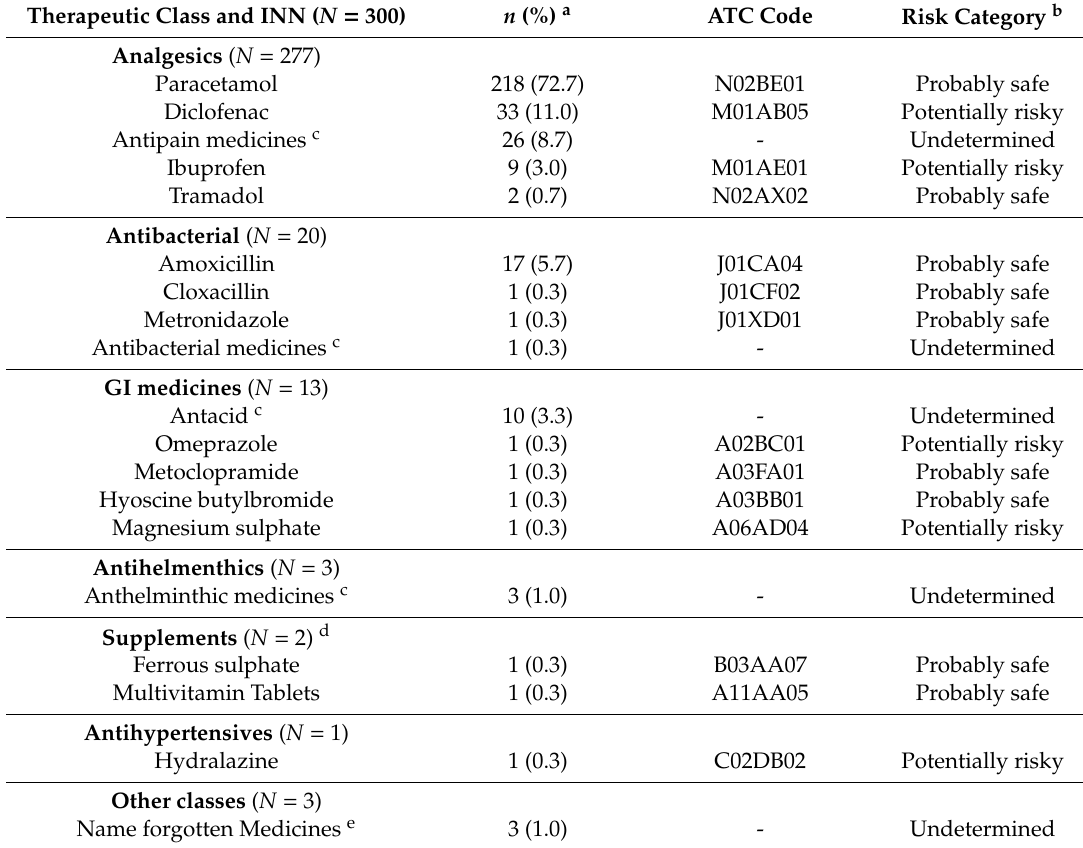
Table 2. Self-medication practice among pregnant women prior to Jimma University Medical Center (JUMC) admission and modified medicine risk classification, Ethiopia, February to June 2017. Therapeutic Class and INN ( N =